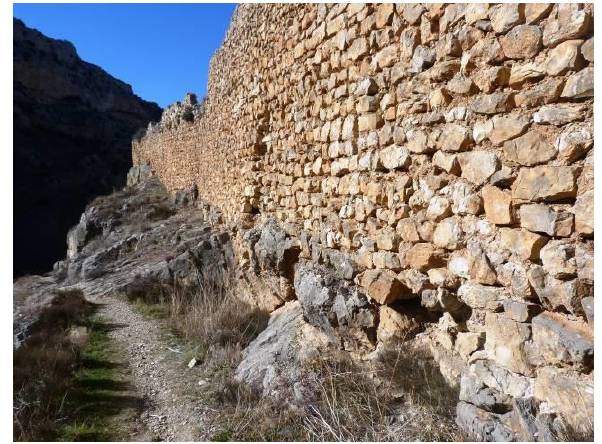
Figure 5. City wall of Albarracín, outer face of the Torre Blanca section (F. J. Gómez-Patrocinio).